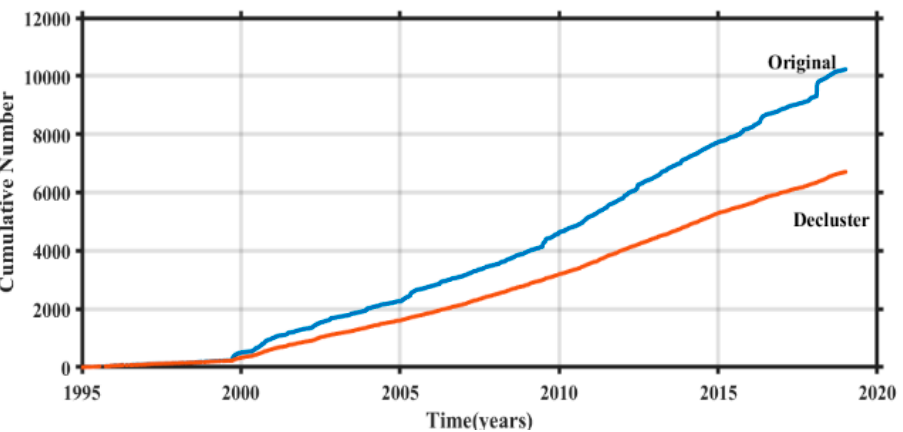
Figure 2. Variations of magnitude completeness M C value from 1995 to 2019 in the Taiwan region. Standard deviation ( δ M C ) of the completeness (dashed lines) is also given. M C is plotted for overlapping samples, each containing 200 events.